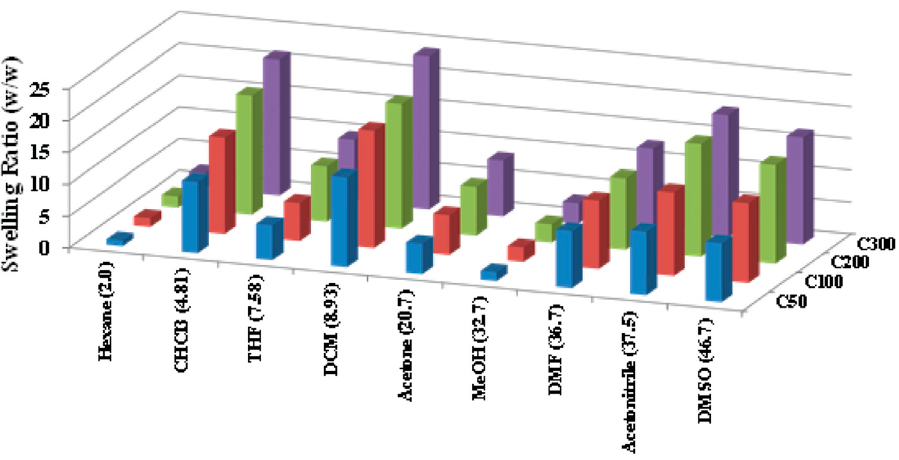
Figure 4. Swelling behavior of different carbohydrate based organogels in various organic solvents. Table 2. Swelling ratios ( w/w ) of carbohydrate based organogels after 24h in different organic solvents (the tea tree oil (TTO):polyvinyl alcohol (PVA) is an emulsion of 40% TTO, 60% water (10% w / v PVA)). Gel Isopropyl Palmitate Isopropyl Myristate Olive Oil SSC SSH TTO:PVA C50 0.12 0.08 0.15 0.21 0.25 1.59 C100 0.30 0.18 0.76 0.42 0.56 1.09 C200 0.39